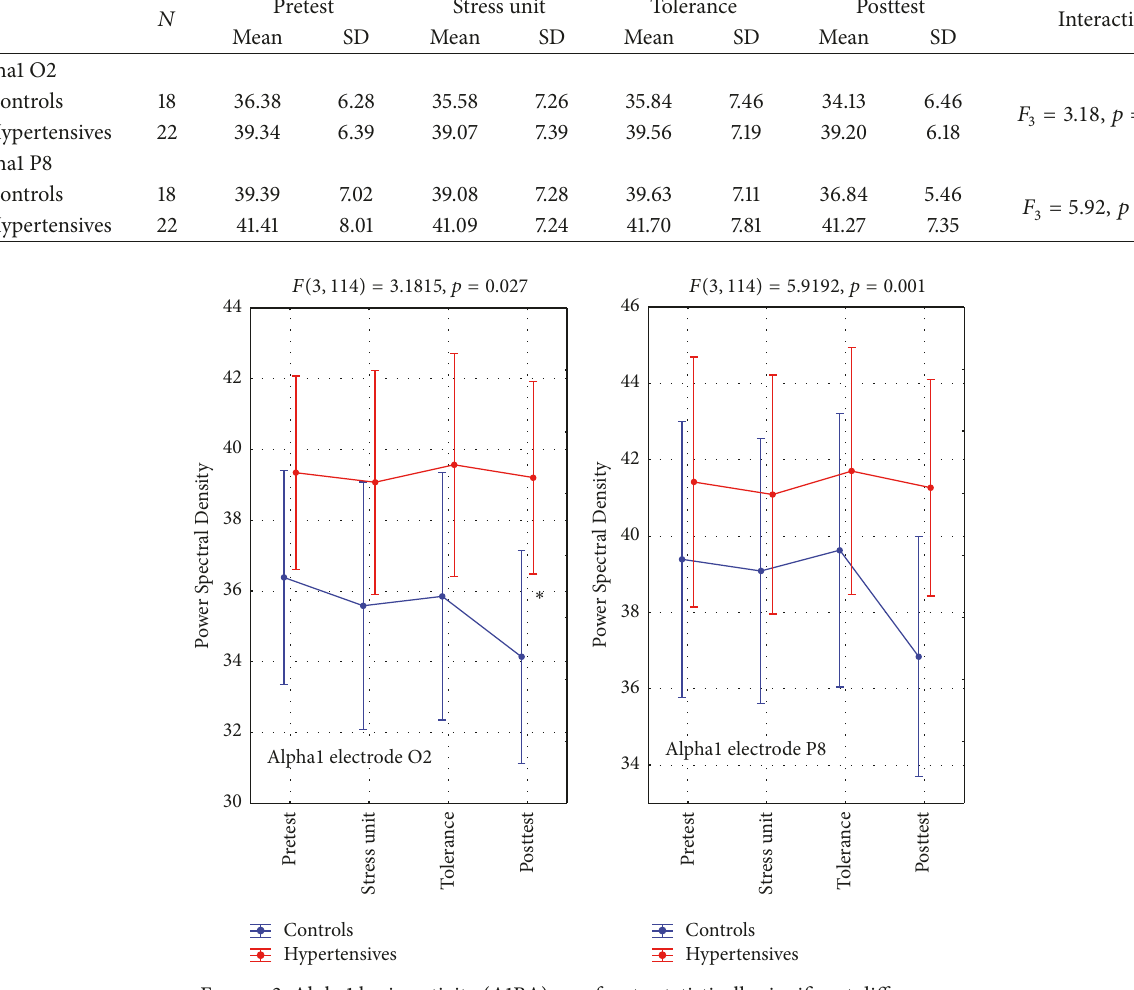
Figure 3: Alpha1 brain activity (A1BA). ∗ refers to statistically significant